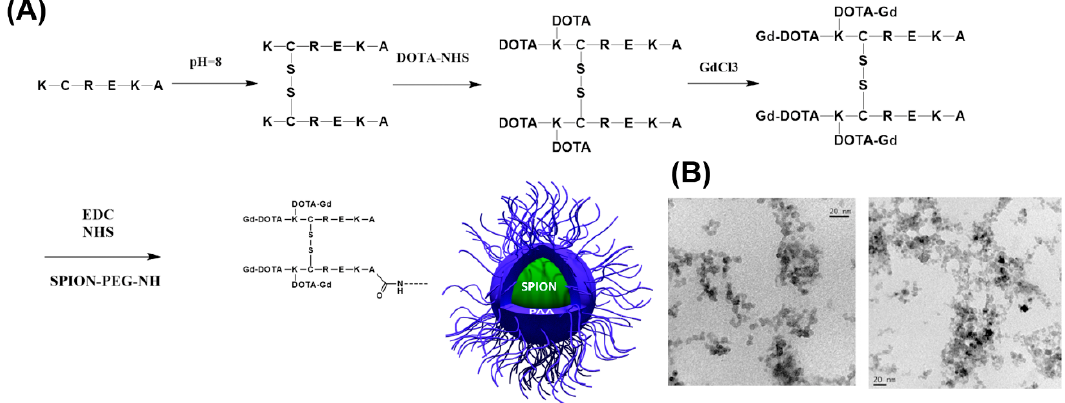
Figure 1. ( A ) Schematic representation of the synthesis of KCREKA-NPs starting from the protected KCREKA peptide. ( B ) TEM images of the KCREKA-NPs.